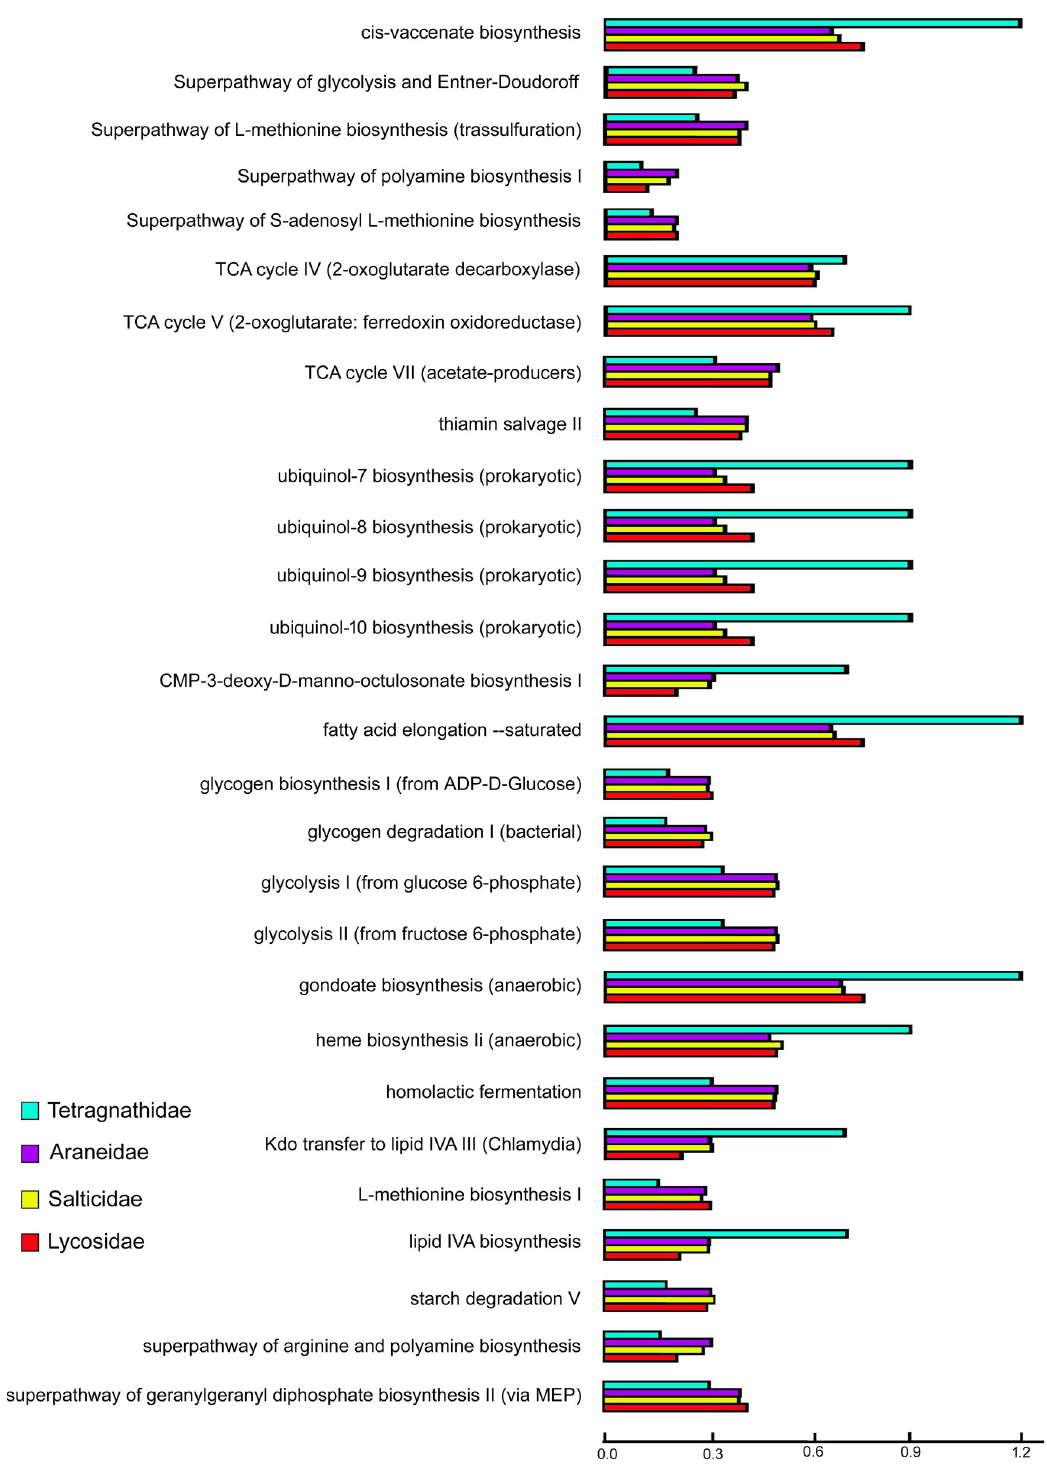
Fig 7. Representation of the common predicted functional metabolic pathway between four spider families.